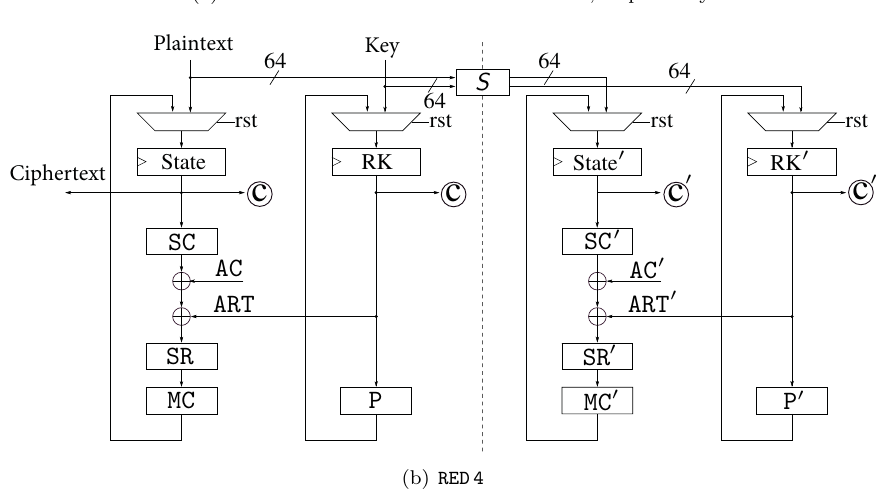
Figure 3: Block diagram of the round-based SKINNY-64-64 encryption RED 1 , RED 3 , and RED 4 implementations. The left part of each design depicts the original encryption function, and the right part the predictor circuit, corresponding to A and A 0 given in Figure